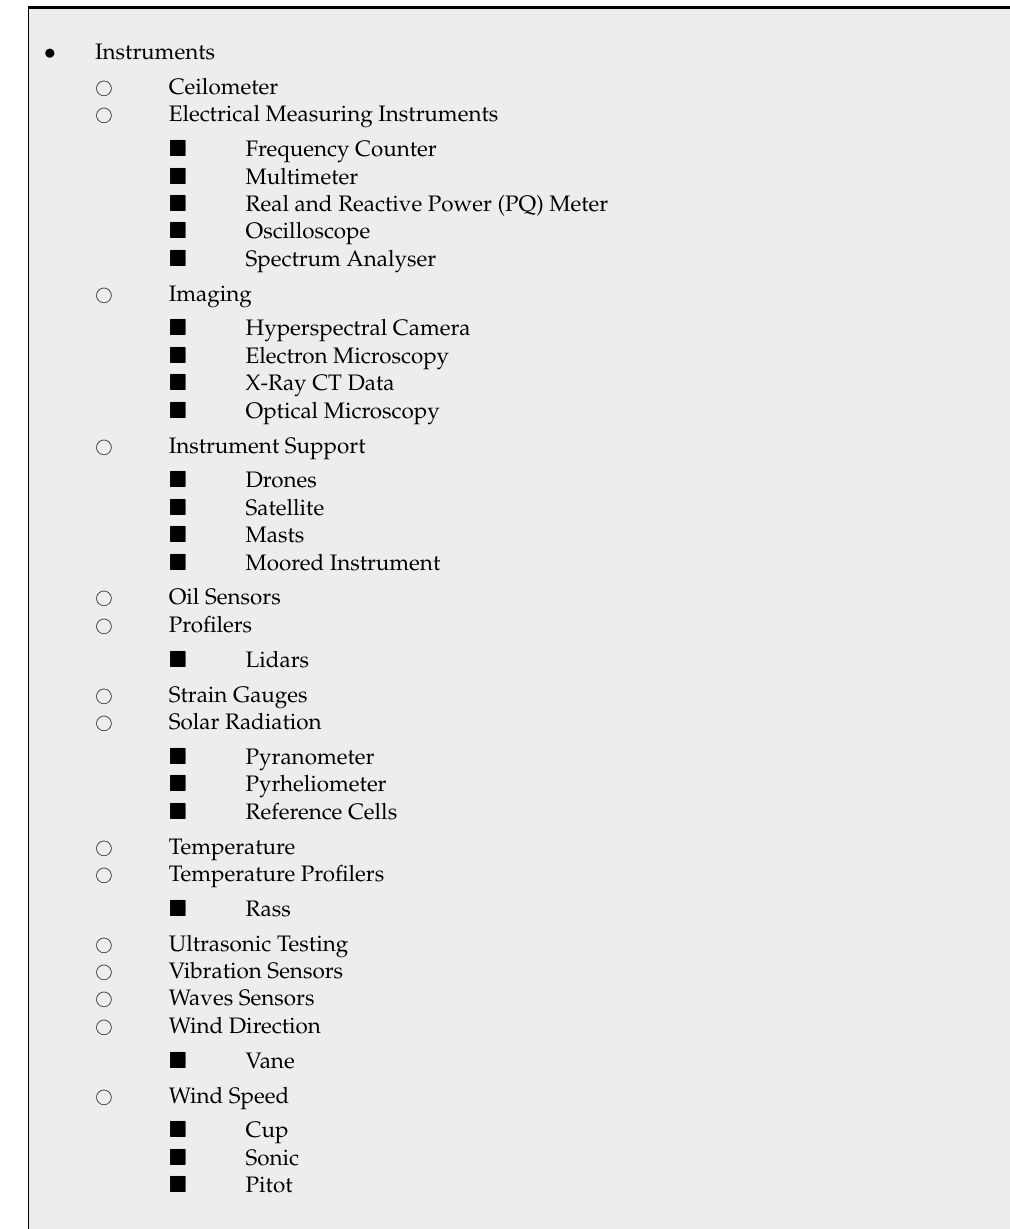
Table 19. Hierarchy for Instrument-related